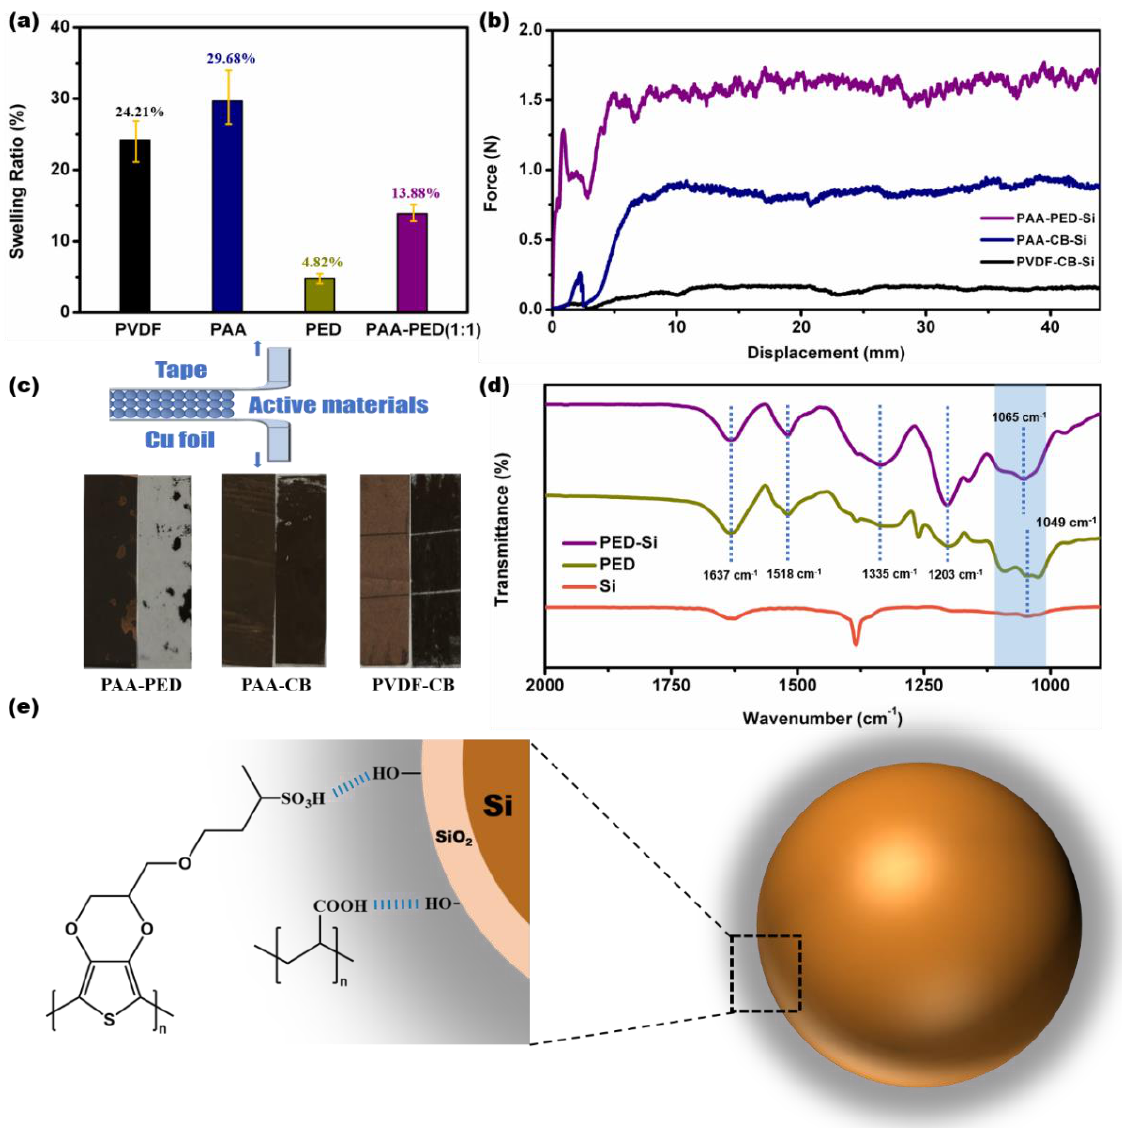
Figure 2. ( a ) The swelling ratios of different binders in the electrolyte; ( b ) 180° peeling test of PAA − PED − Si, PAA − CB − Si, and PVDF − CB − Si electrodes; ( c ) schematic illustration of peeling test and photos of the above electrodes after peeling ( left ) and active materials fallen off on tapes ( right ); ( d ) FT − IR spectra of PED, Si NPs, and mixture of both PED and Si NPs; ( e ) schematic illustration of the dual H − bond interactions between PAA/PED with Si NPs in the electrode.